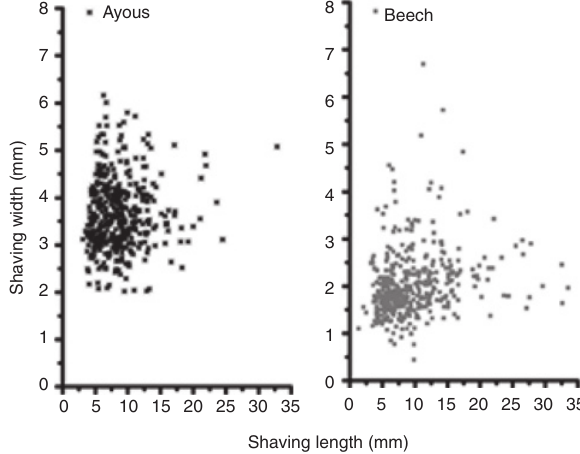
Figure 2: Width versus length for the two types of wood shavings.